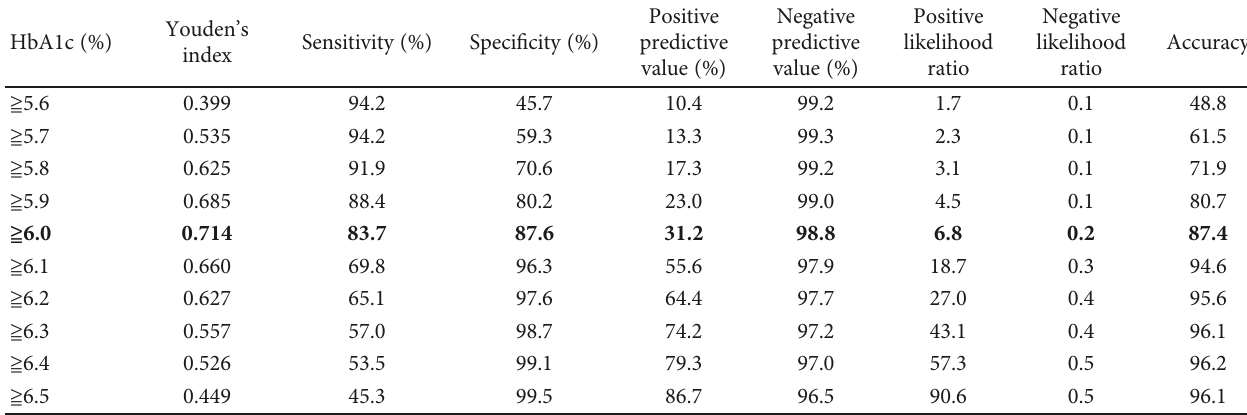
Table 3: Sensitivity, speci fi city, positive and negative predictive values, positive and negative likelihood ratios, and accuracy for detecting diabetes de fi ned by